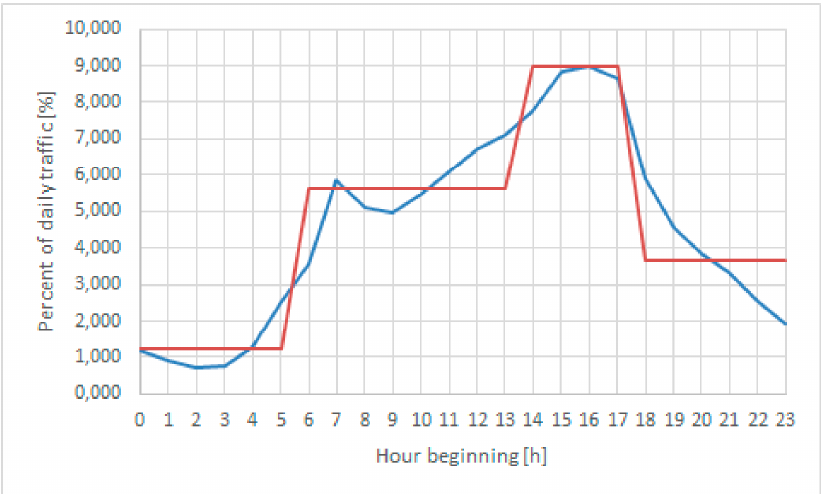
Figure 6. Daily flow for local route (in blue real data, in red the constant piecewise approximation that was used in the simulations).